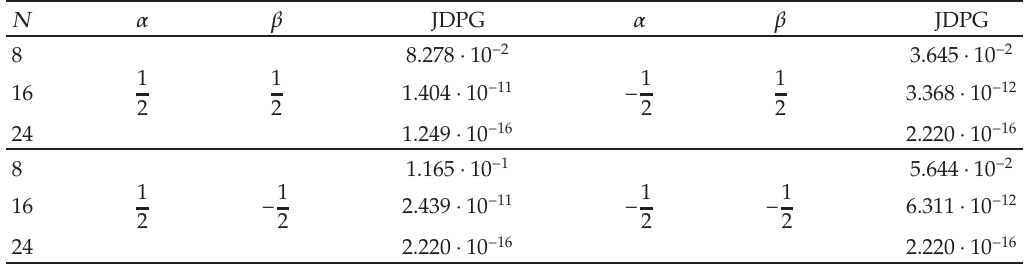
Table 1: Maximum pointwise error using JDPG method for N (cid:6) 8 , 16 , 24, for Example 5.1. N α β JDPG